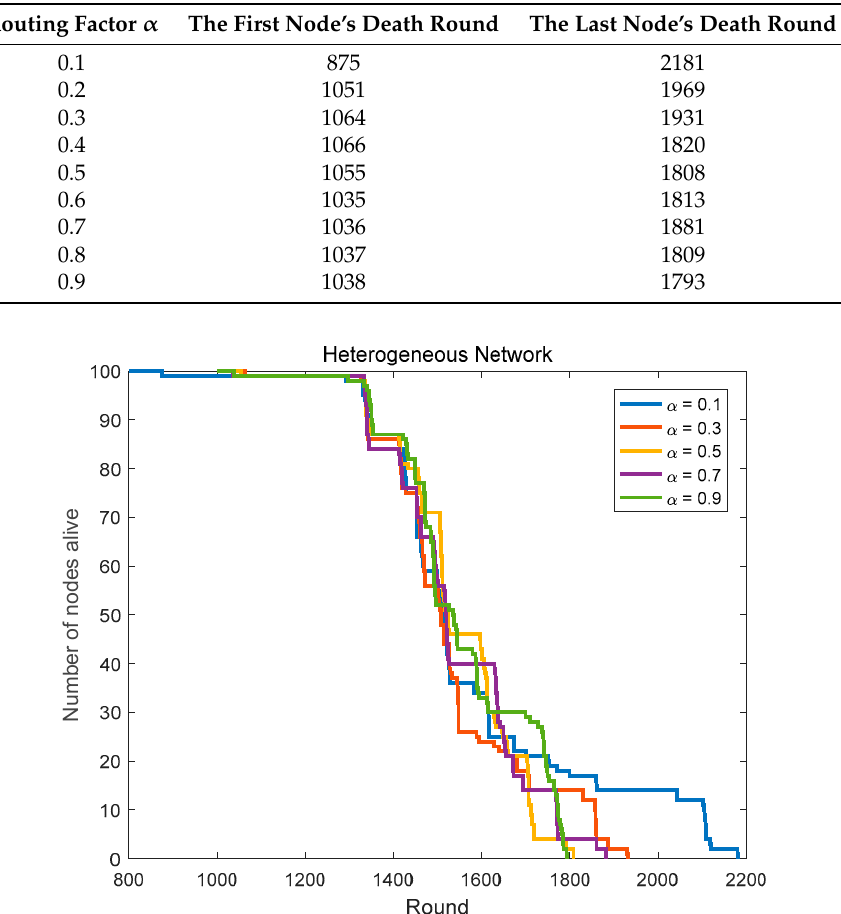
Figure 11. The network lifetime comparison in heterogeneous networks (routing factor = 0.1, 0.3, 0.5, 0.7 and 0.9).